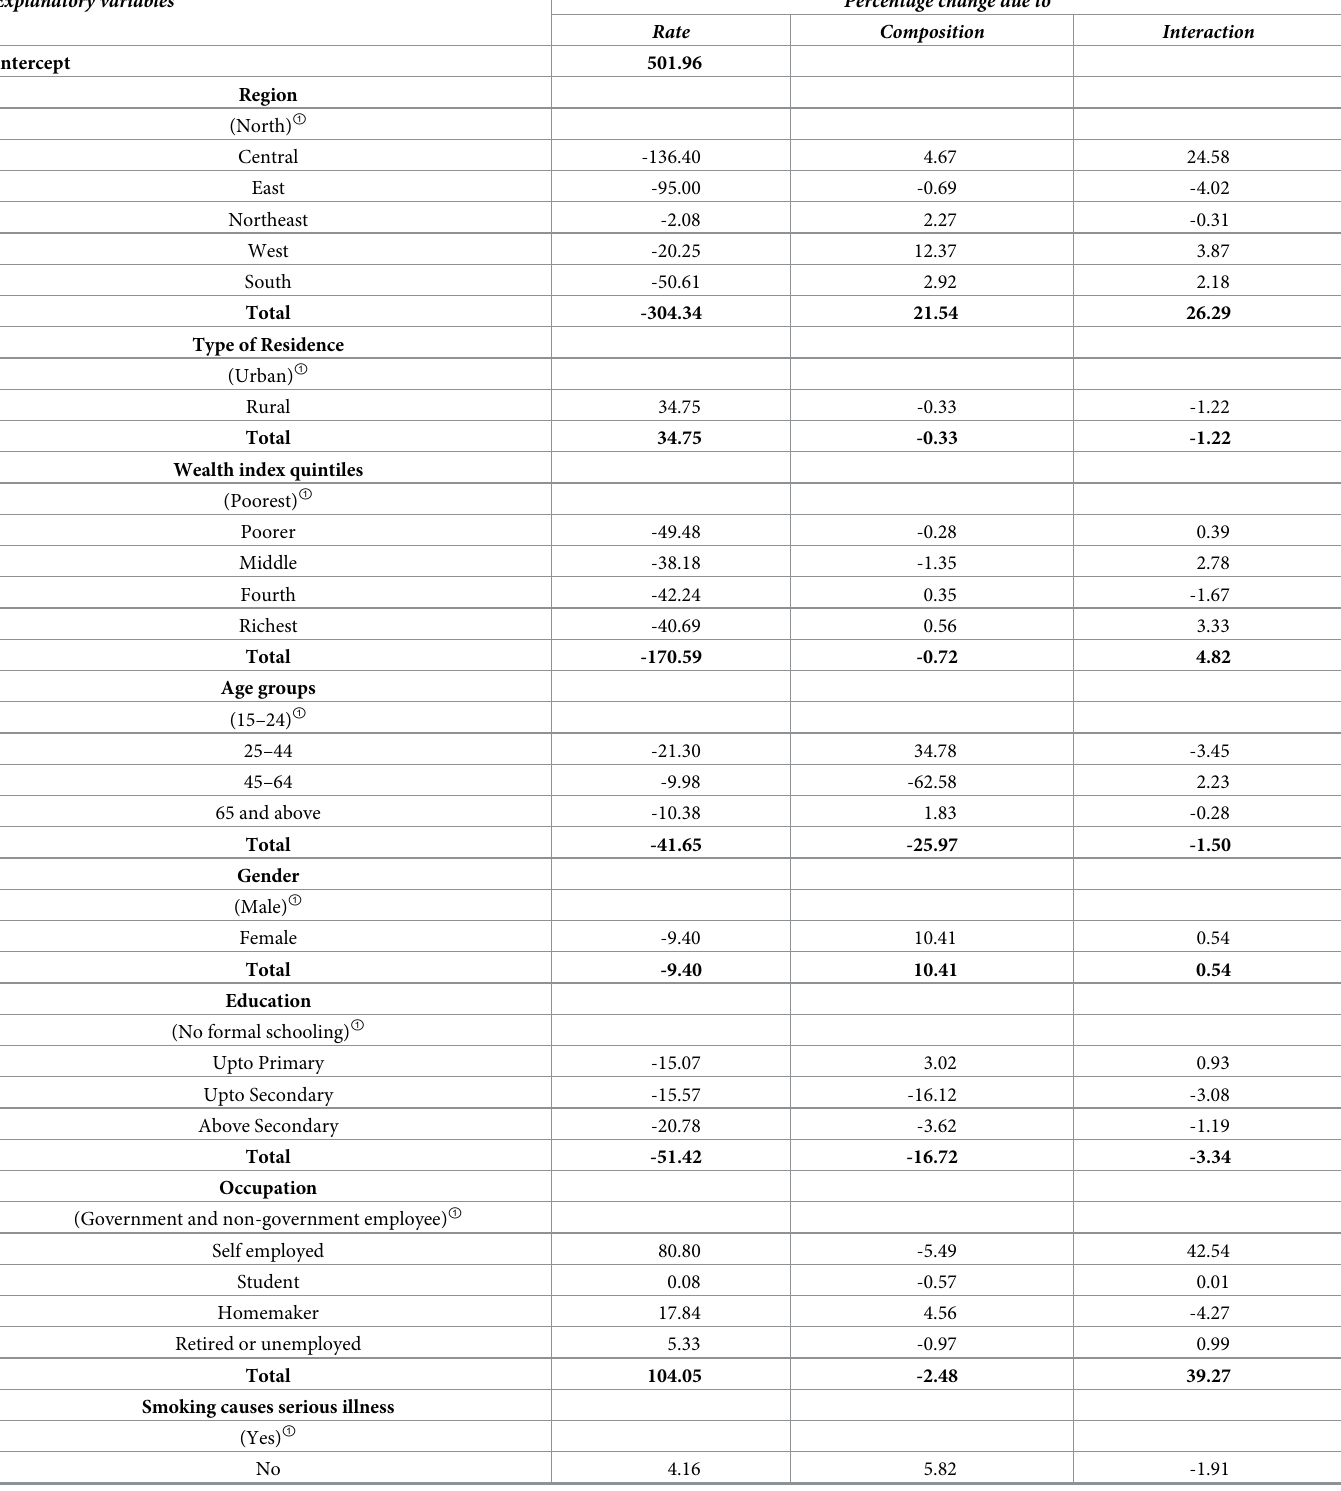
Table 4. Decomposition of change in smoking by using multivariable binary logistic regression model in India, 2009–10 and